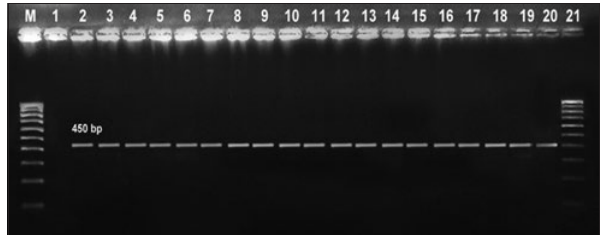
Figure-1: Agarose gel showing polymerase chain reaction product specific for genus Campylobacter spp. (16 SrRNA ), Lane M: 100bp ladder, Lanes 1-7: Campylobacter isolates (816 bp).